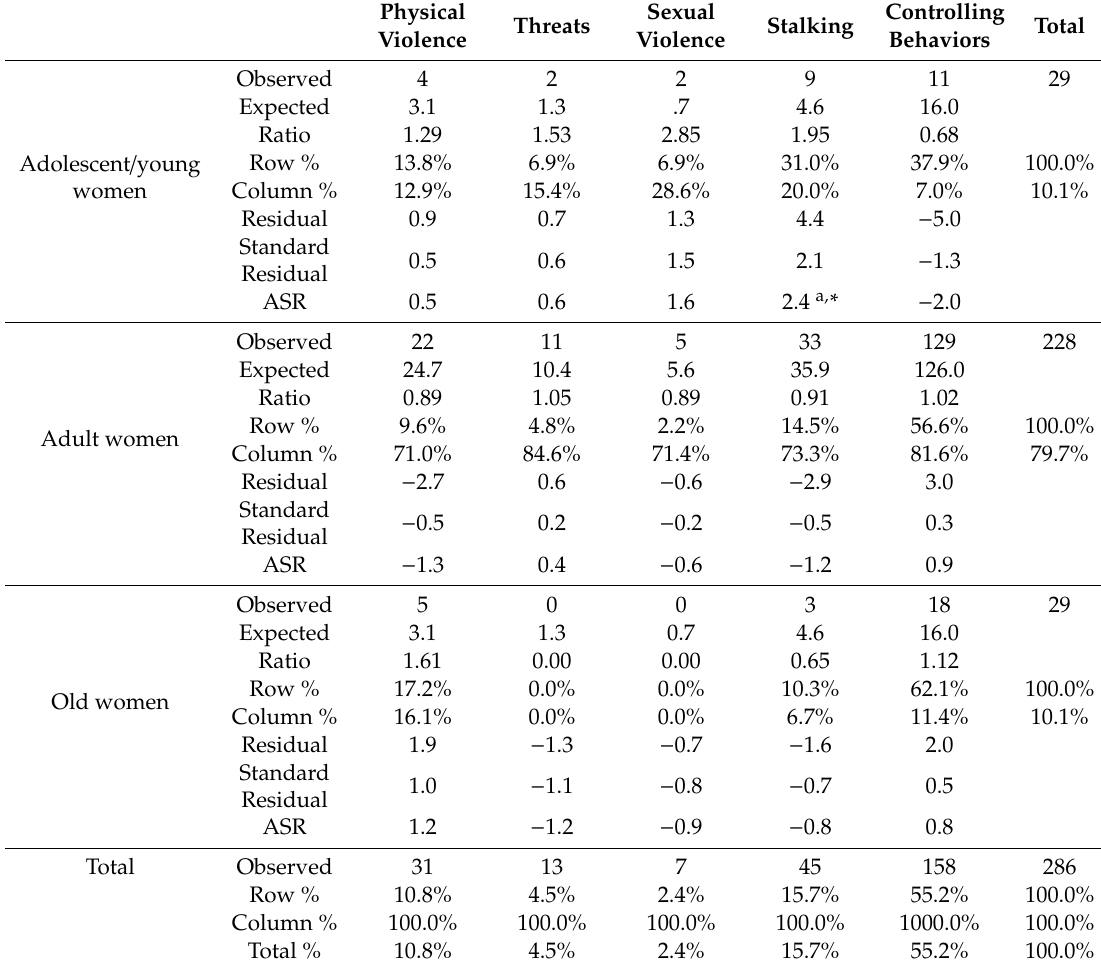
Table 3. Types of violence across women’s age